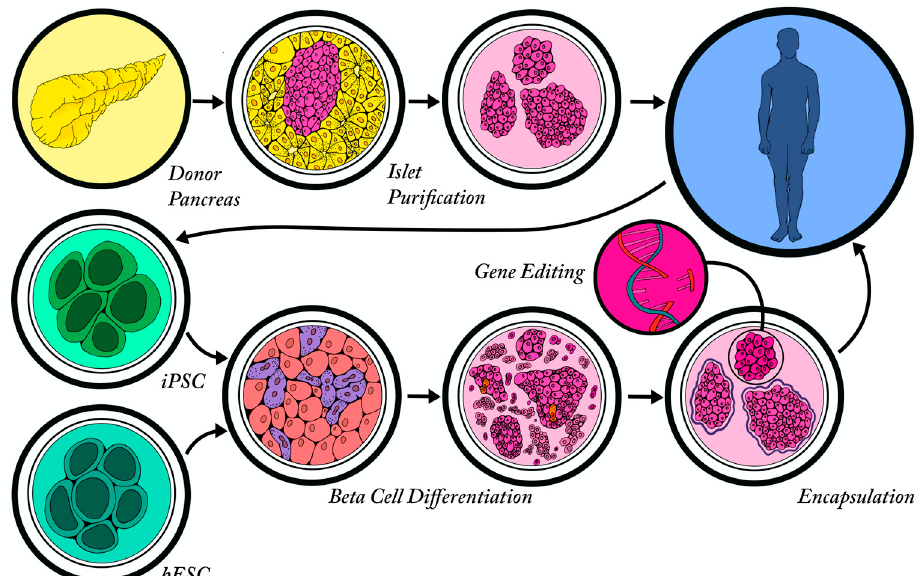
Figure 4. Exogenous sources of beta cells. Exogenous beta cells can be purified from cadaveric beta cells isolated from a donor pancreas and transplanted into a T1D patient following the Edmonton protocol. Alternatively, terminally differentiated cells can be isolated from an individual and reprogrammed into iPSCs, followed by directed differentiation in vitro to form stem cell-derived beta-like cells (sBCs). In addition, hESCs can be differentiated to form non-patient specific sBCs. The sBCs from both iPSCs and hESCs can be genetically manipulated or encapsulated to help them evade the patient’s immune system following